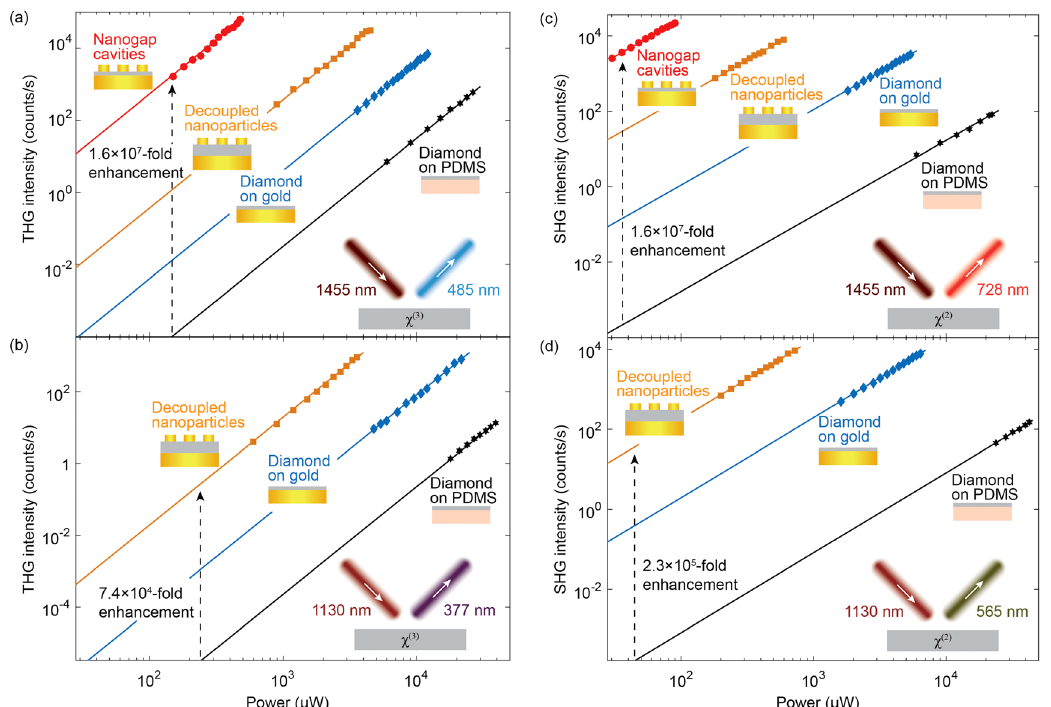
Figure 2: (a and b) Third-harmonic generation (THG) intensity as a function of excitation power shown on a log scale. Data points are experimentalresults,andlinesarecubicpolynomialfits.(a)1455nmexcitation.(b)1130nmexcitation.(candd)Second-harmonicgeneration (SHG)intensityasafunctionofexcitationpowershownonalogscale.Datapointsareexperimentalresults,andlinesarequadraticpolynomial fi ts. (c) 1455 nm excitation. (d) 1130 nm excitation. Nanogap cavities: transferred nanoparticles on ∼ 12 nm diamond with an underlying gold fi lm; decoupled nanoparticles: transferred nanoparticles on ∼ 200 nm diamond with an underlying gold fi